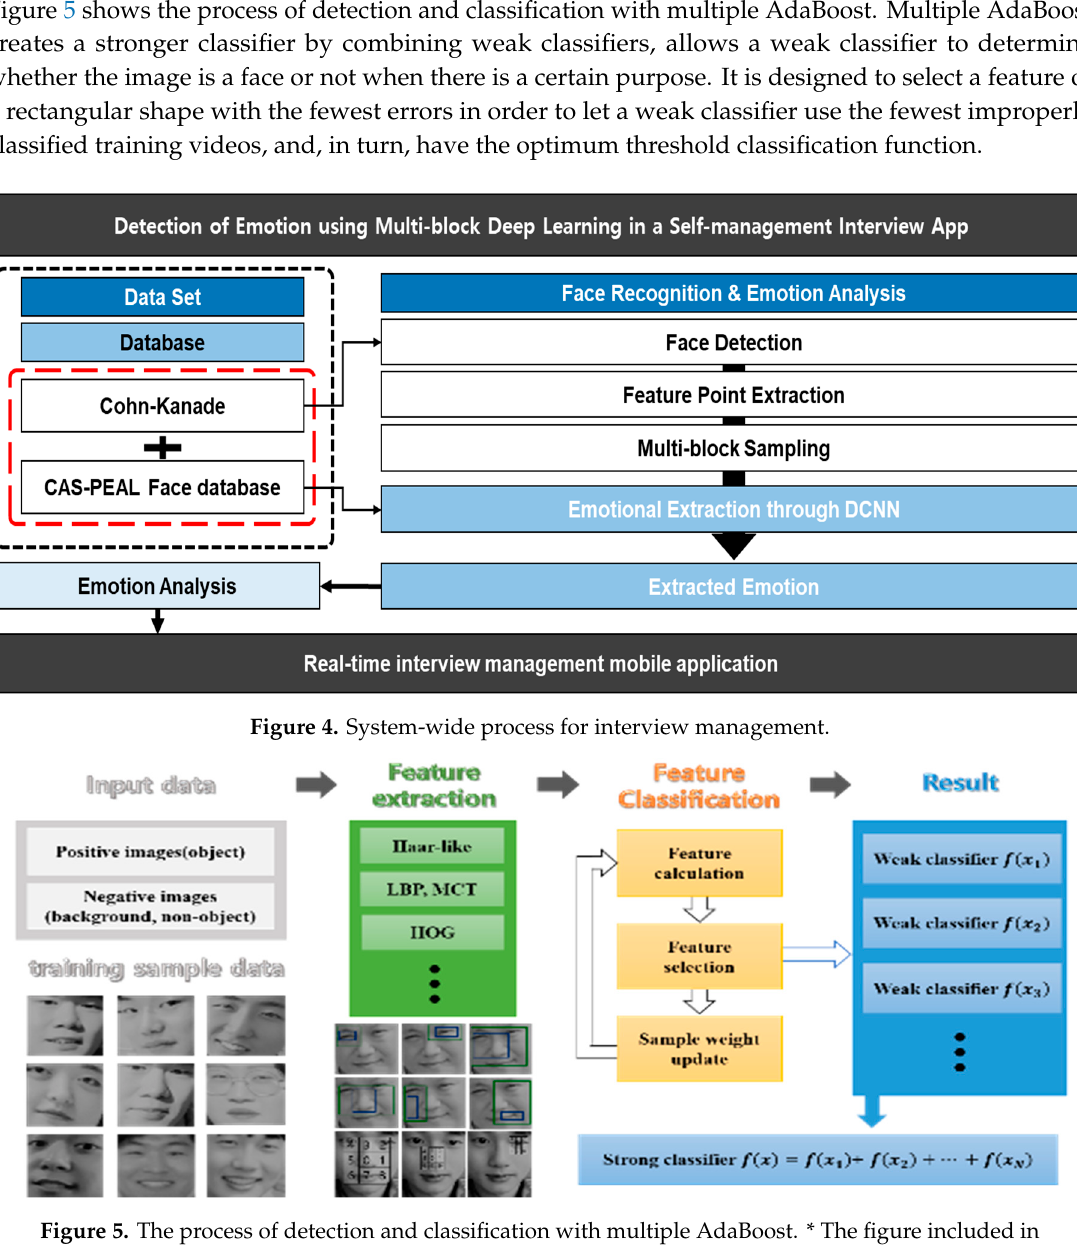
Figure 5. The process of detection and classification with multiple AdaBoost. * The figure included